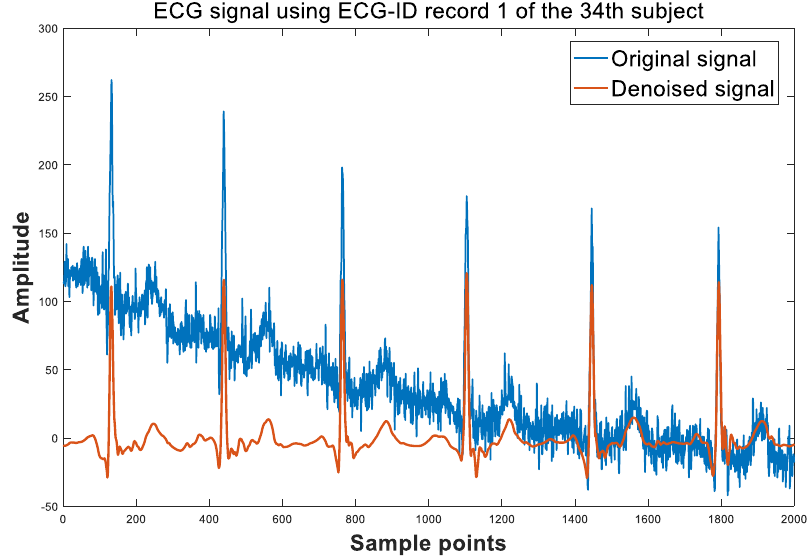
Figure 2. Comparison between the original signal and the de-noising signal.